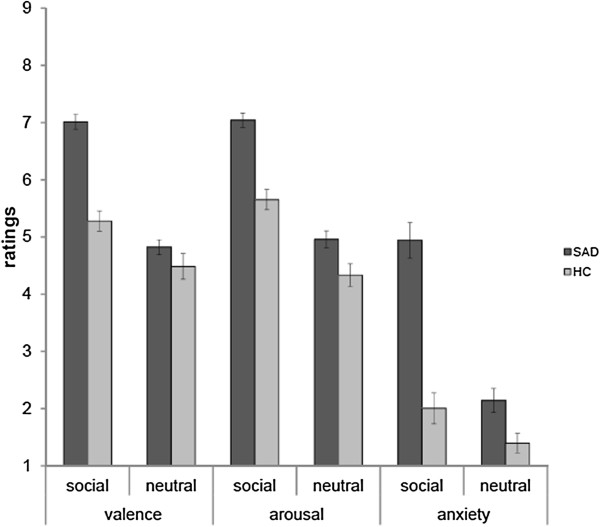
Valence, arousal, and anxiety ratings (mean ± standard error) for social and neutral video clips in patients with social anxiety disorder (SAD) and healthy control participants (HC).